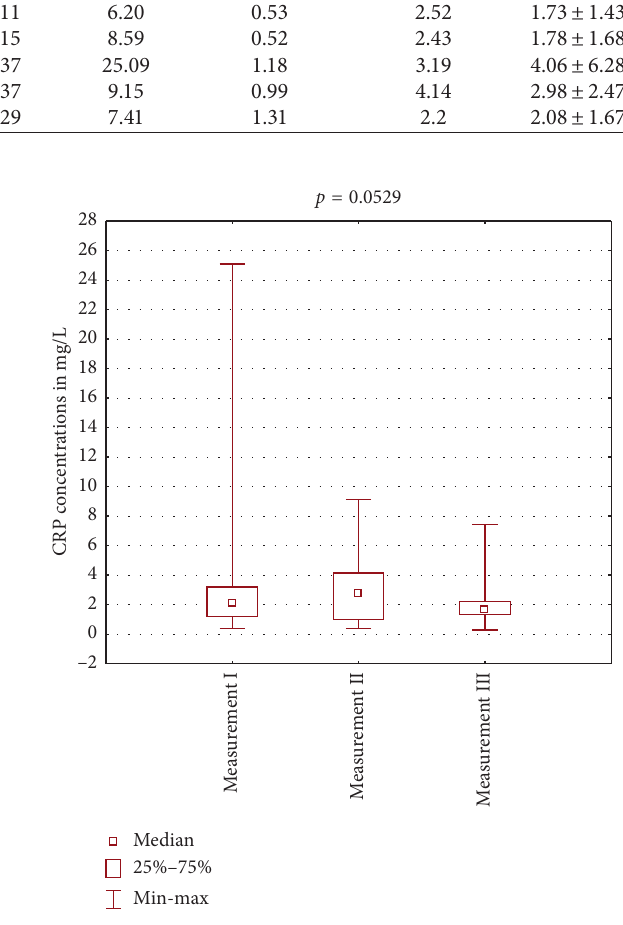
Figure 2: In-group comparisons of the results of measurements I, II, and III—the control